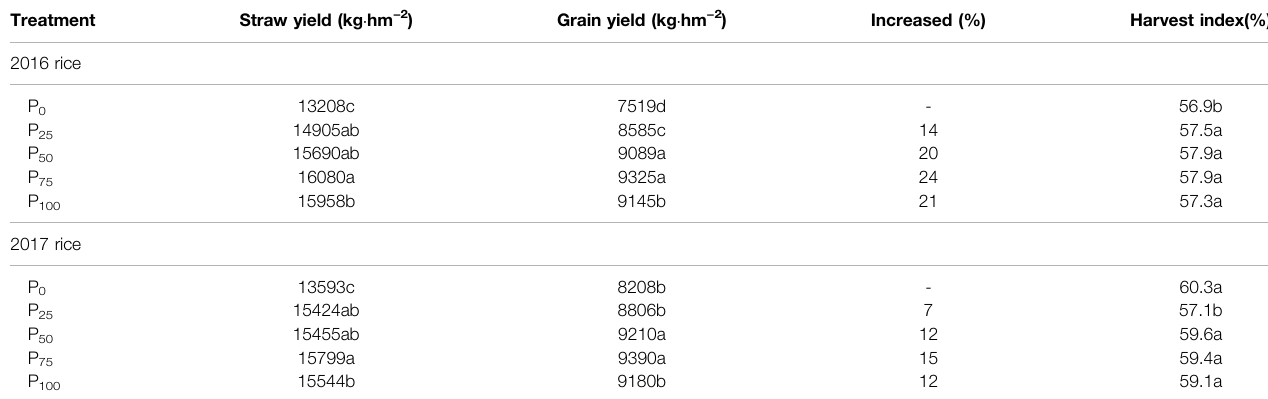
TABLE 2 | Effect of P fertilization rates on rice yield.